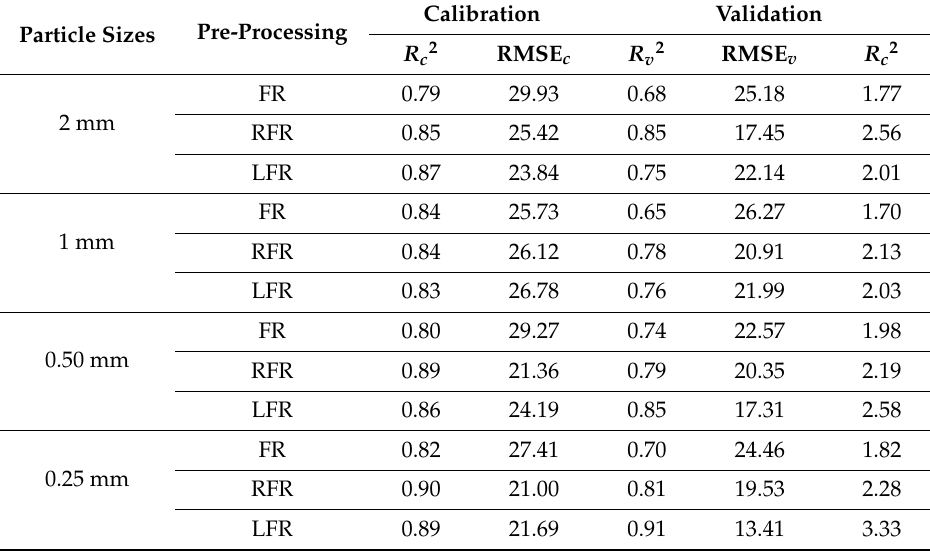
Table 5. Modeling results of partial least squares regression (PLSR) for SOM